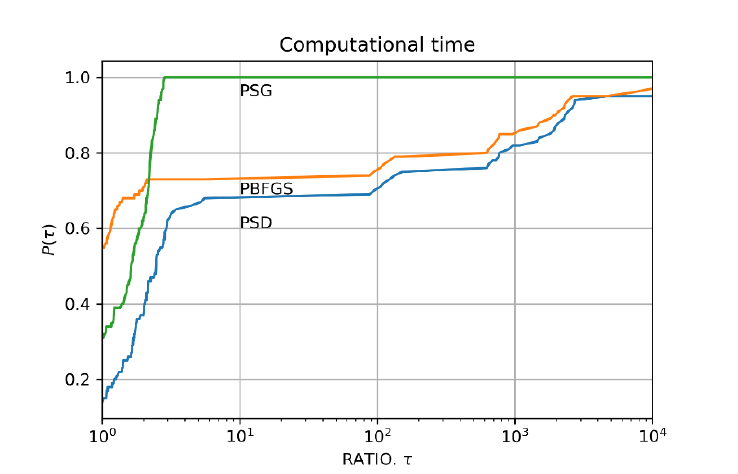
Fig. 3. Comparison of methods in terms of CPU time in